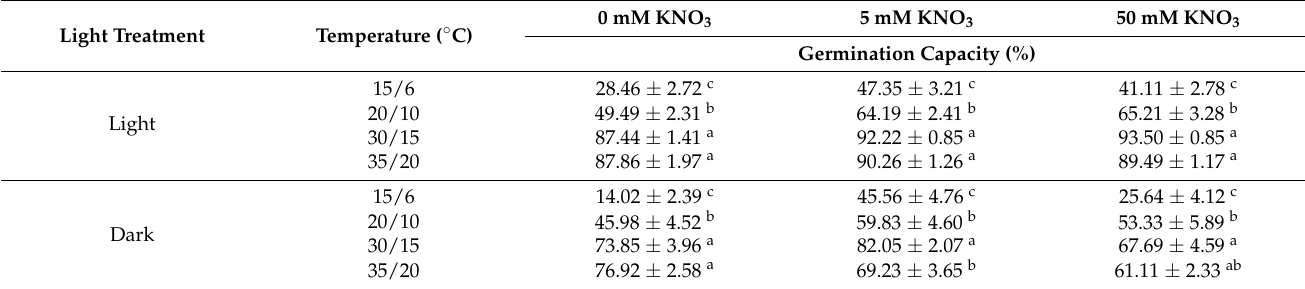
Table 2. The effect of alternating temperature and applied KNO 3 concentration under the different light conditions on the germinative capacity (GC) of S. lanceolatum .